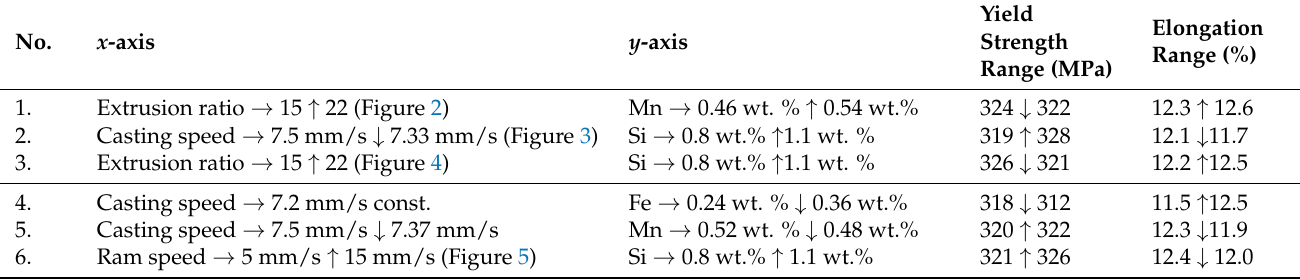
Table 5. Values for yield strength and elongation at certain values for different contents and process parameters, where one mechanical property increases while another decreases. Symbols ↑ and ↓ represent increase and decrease of the property,